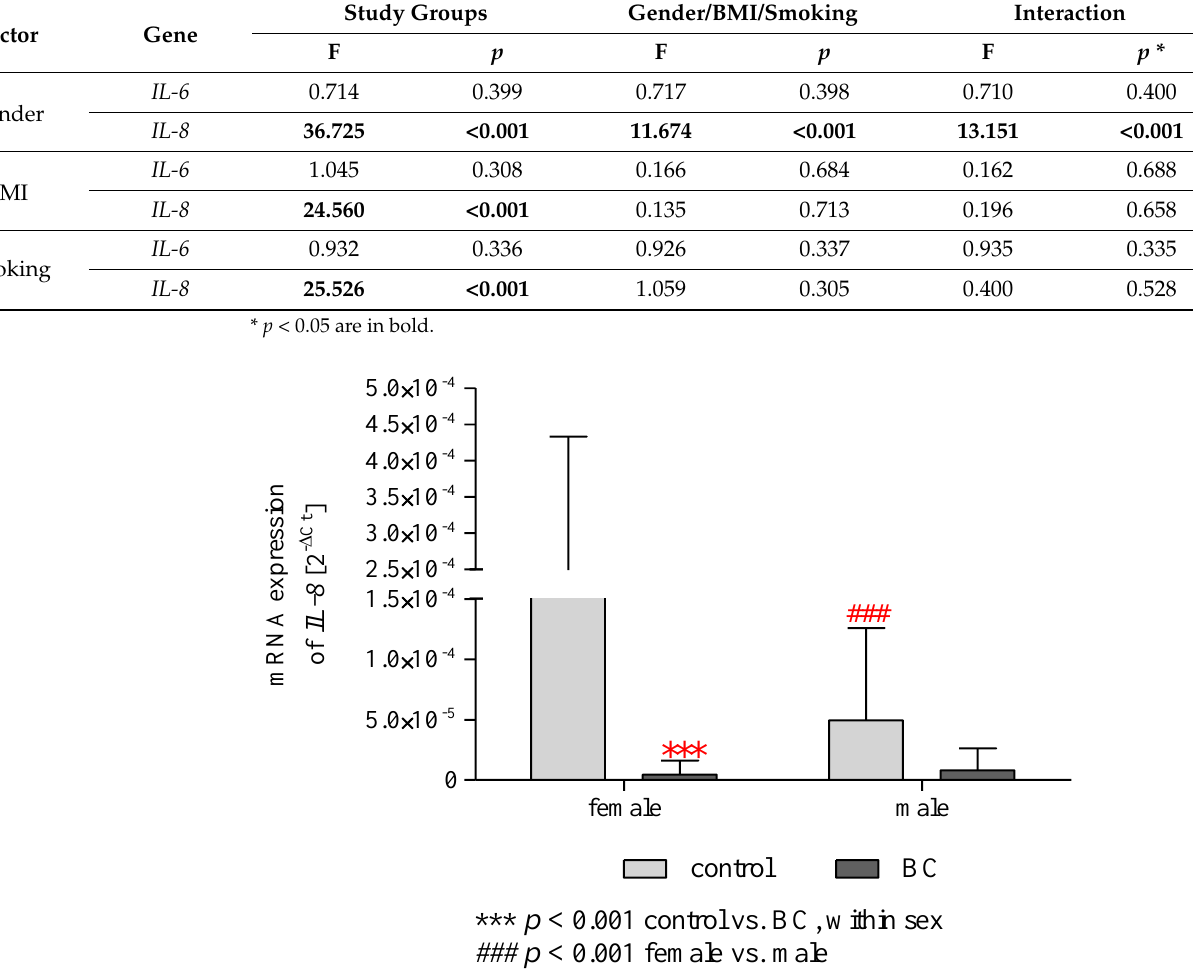
Figure 6. Methylation status of the IL-6 promoter region in PBMCs. The data are plotted as individ- ual values and the median with interquartile range is indicated by the horizontal bars; ***— p < 0.001. 2.14. Methylation of the IL-6 Promoter Region and Correlation with Size or the Direct Extent of the Primary Tumour, the Status of Lymph Node Metastasis, Distant Metastasis According to the TNM Classification, and the Grading of Histological Malignancy We verified the impact of primary tumour size (Figure 7A), the status of lymph node metastasis (Figure 7B), distant metastasis (Figure 7C), and the grading of histological ma- lignancy (Figure 7D) on the methylation level of the IL-6 promoter region. For this pur- pose, similarly to the expression level analyses, we divided them into appropriate sub- groups [26,27]. We found that BC patients with T1 status primary tumour size were